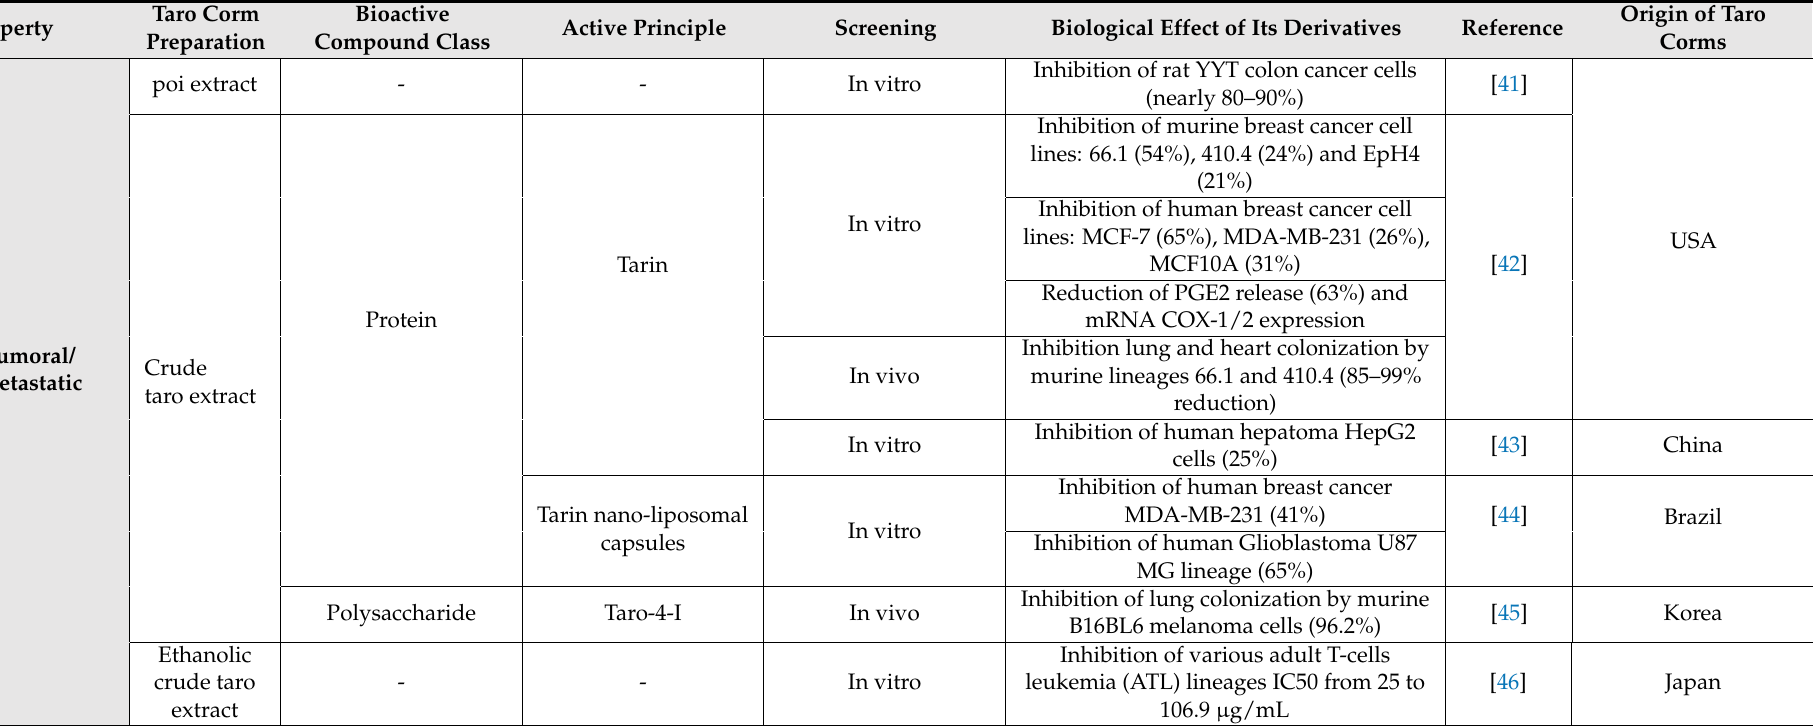
Table 2. Protective and therapeutic potential of taro